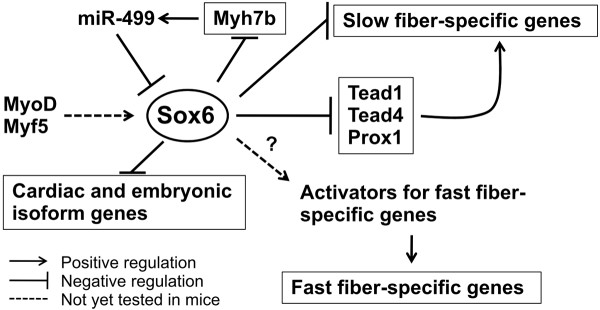
Summary of the present work concerning the fiber type specification under the control of Sox6. It has been shown that in zebrafish, MyoD and Myf5 are necessary to activate Sox6 gene expression in muscle [100]. This muscle-specific Sox6 activation mechanism has not been tested in mice yet, but since Sox6 upregulation coincides with upregulation of these myogenic regulatory factors during muscle differentiation, it is very likely that this mechanism is shared in mice also (see text). Once expressed in muscle, Sox6 directly suppresses transcription of slow fiber specific, cardiac and embryonic isoform genes during muscle development. In addition to these structural protein genes, Sox6 suppresses expression of the transcription factors which have been shown to activate slow fiber specific genes, Tead1, Tead4, and Prox1. By unknown mechanisms, fast fiber-specific gene expression in Sox6 KO skeletal muscle is dramatically reduced. Since Sox6 is preferentially expressed in fast-twitch fiber rich muscles, it is possible that Sox6 indirectly stimulates the fast fiber-specific gene program. This idea awaits future investigation. Sox6 activity in slow fibers is suppressed by miR-499 which is encoded in an intron of the Myh7b gene. We have shown that Sox6, in turn, suppresses Myh7b transcription. This negative feedback loop might be important for fiber type switching during muscle development as well as in adult muscle.